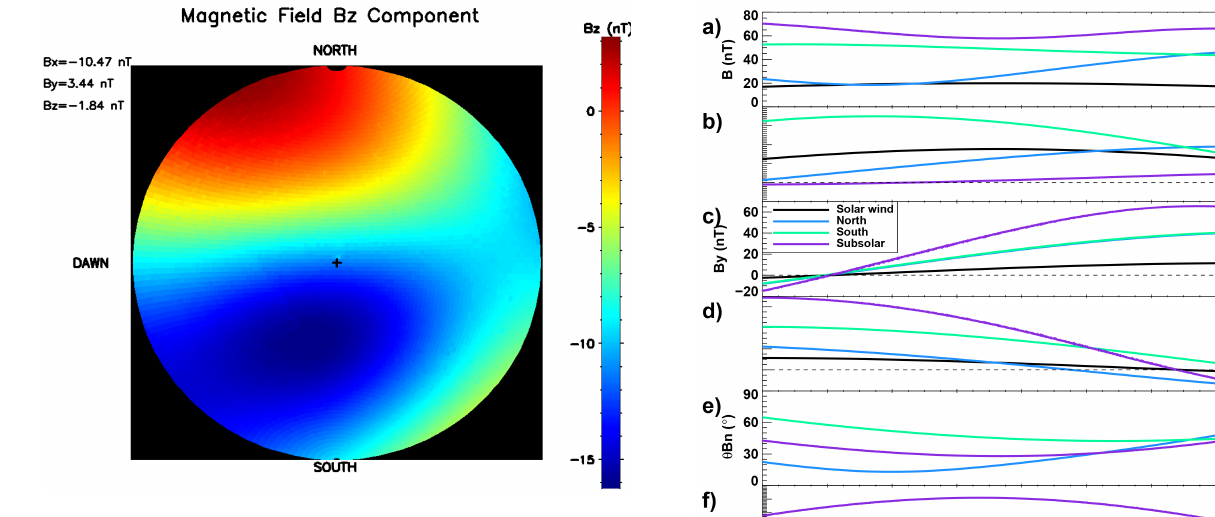
Fig. 9. Colour map of the B z component in the magnetosheath along the magnetopause during a fully south MC, encountered far from its centre, when the axis is located at x =1000 R E . The centre of the plot corresponds to the subsolar point. The radial distance from the subsolar point is proportional to the zenithal angle. The magnetic field components indicated on the upper left of the map are the solar wind magnetic field inputs.